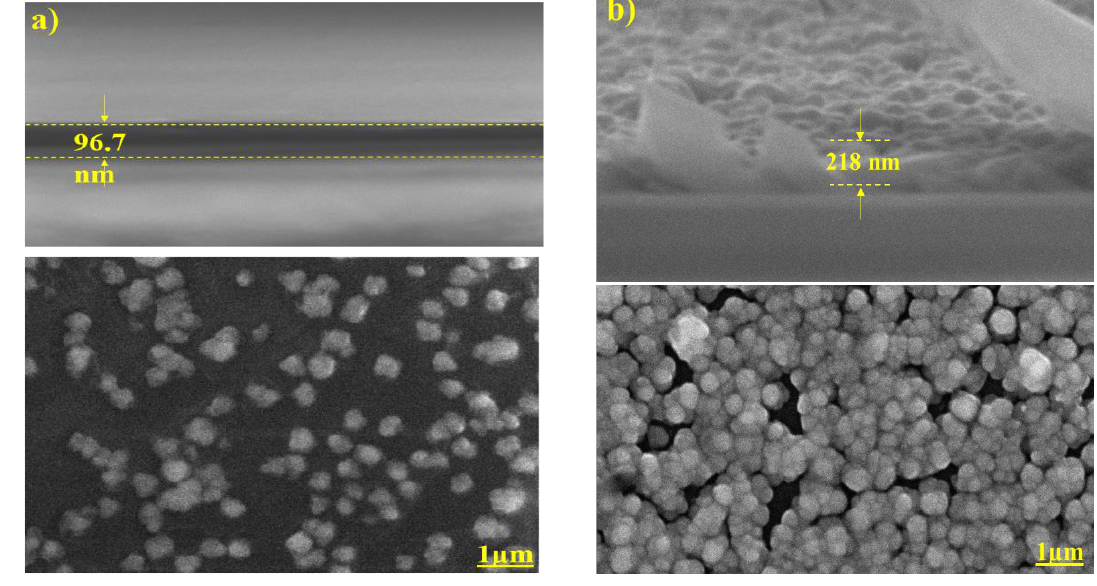
Figure 7. SEM micrograph of CdS thin film at; ( a ) [1/0.75], ( b ) [1/1], ( c ) [1/5], ( d ) [1/25]. The morphology of the films could have a direct influence on the samples ’ electrical and optical characteristics [55]. These micrographs illustrate that the resulting film has high coverage and less pinholes or cracks. As thiourea concentration is altered from 0.0015 M to 0.05 M, the grain size increased, and it can be seen from Figure 7 of the sample. At low S −2 concentration, i.e., in the [1/0.75] sample, there is no cluster forming, and the de- posited surface is smoother and more uniform compared with other samples due to the sulphur deficiency. Coupling this finding with the achieved XRD result, it can be con- cluded that no significant CdS deposition has happened compared with other samples, because of the quantity of CdS does not enough to detect by XRD, suggesting that film growth has started with the adsorption of small CdS particles on the substrate [56]. Addi- tionally, the cross-section image for sample [1/0.75] in Figure 7a shows film thickness of 96.7 nm, which comes from unreacted cadmium and sulphur. Additionally, the rate of ion